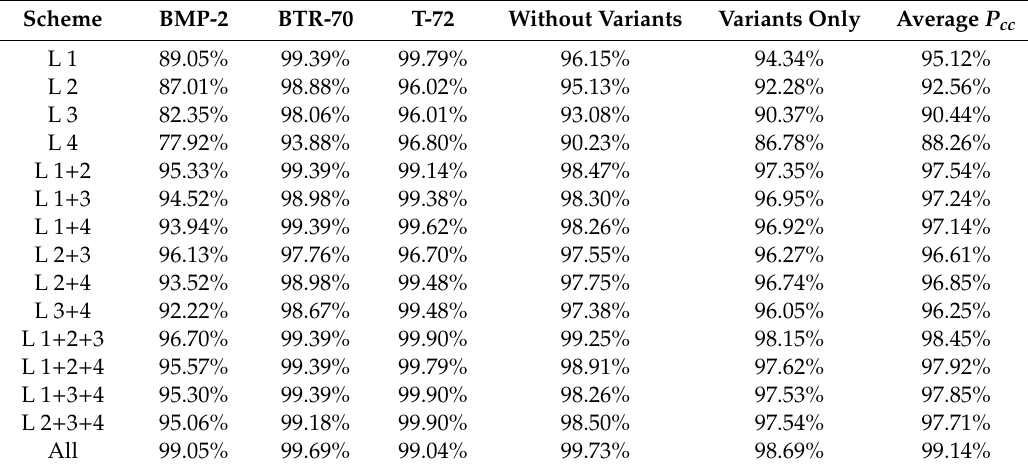
Table 4. Classification results on the three-target